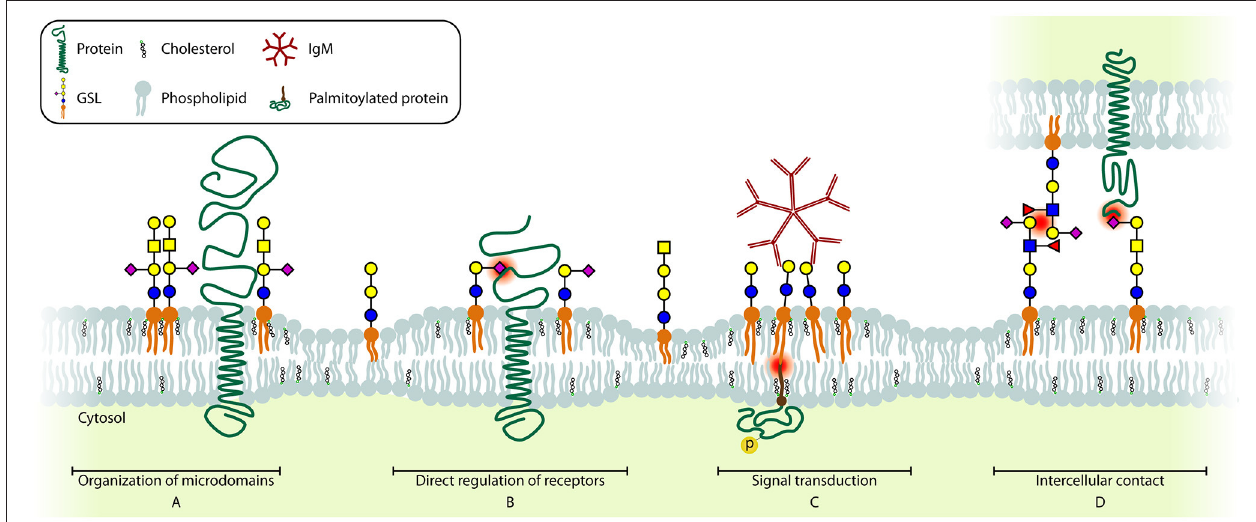
FIGURE 4 | Schematic model of the different GSL functions. Essential glycan-glycan, protein-glycan, and lipid interactions are highlighted (red dot). (A) GSLs are involved in including and (not shown) excluding proteins from microdomains. (B) Several receptors can be directly regulated by GSLs present in the cell membrane. (C) Crosslinking of several GSLs can induce signaling across the membrane. (D) GSLs can interact with glycans (CCI, left) or with proteins (PCI, right) on other cells, contributing to cell-cell recognition and adhesion.